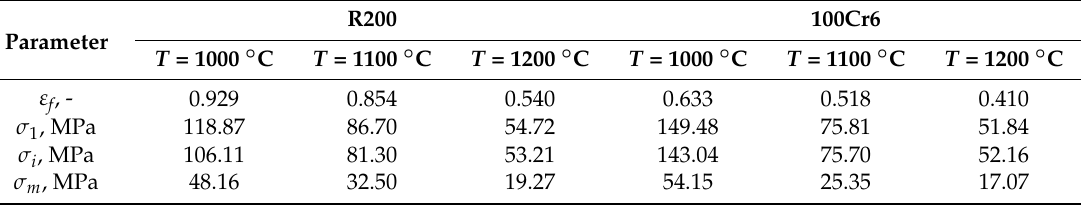
Figure 11. Variations in the effective stress (MPa) measured by the sensors located in the R200 steel sample under the tensile test at 1100 °C. Table 5. Final values of selected parameters used in the tensile testing of R200 and 100Cr6 steels in the temperature range of 1000–1200 °C.